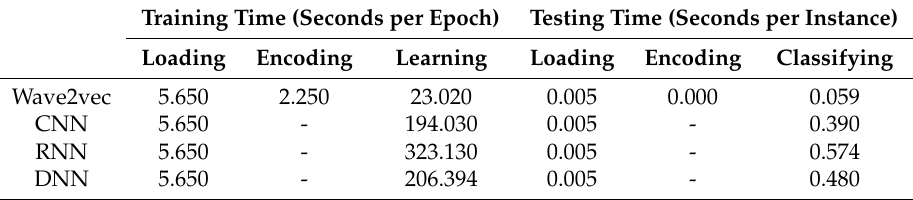
Table 2. Comparison of training time and testing